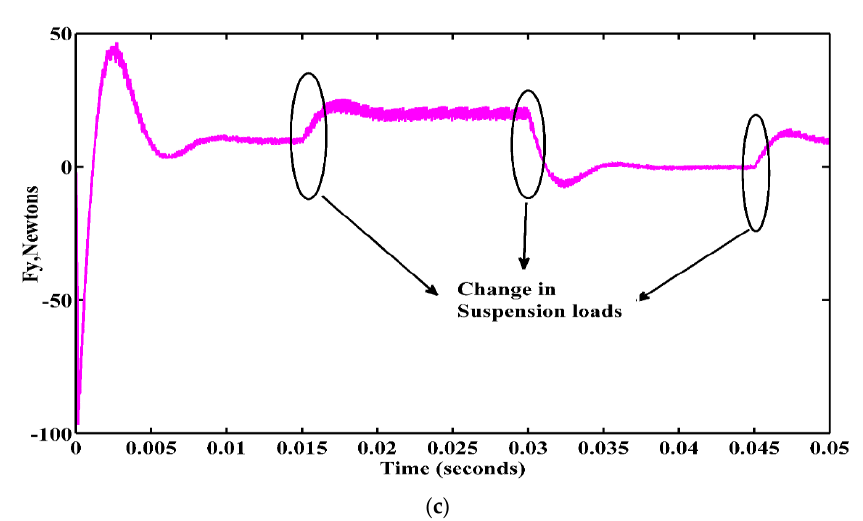
Figure 13. First Quadrant Suspension parameters. ( a ) Rotor Xand Y-axis dispalcements when suspension loads are applied;( b ) Suspension force in the X-direction when suspension loads are applied;( c ) Suspension force in the Y-direction when suspension loads are applied.